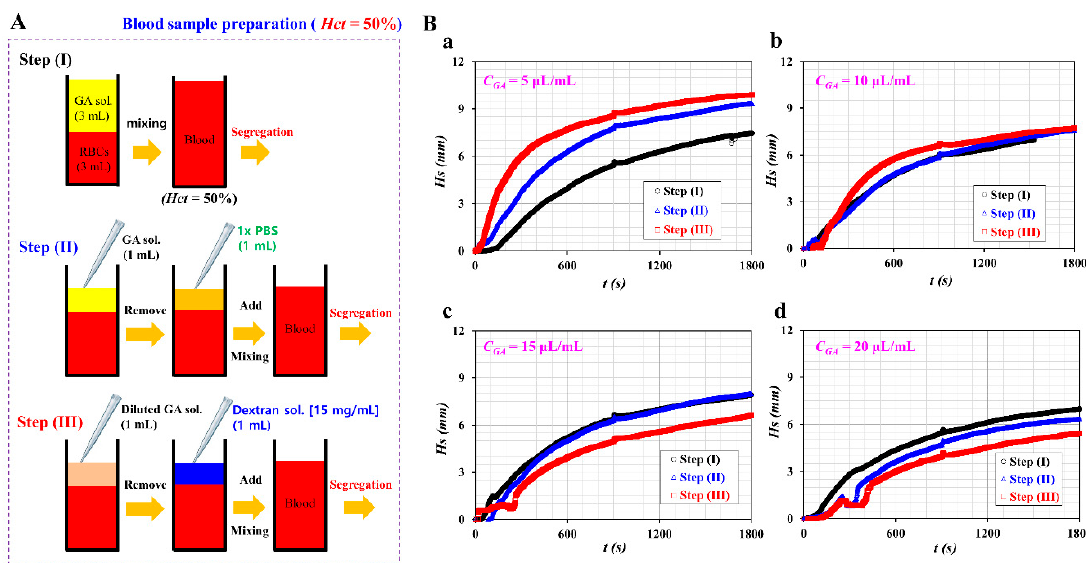
Figure 6. Measurement of separation height ( Hs ) after adding normal RBCs into GA solution, 1x PBS, and dextran solution ( C dex = 15 mg / mL). ( A ) Schematic of the three steps for preparing blood sample. ( a ) Step (I): normal RBCs (3 mL) and a specific concentration of GA solution (3 mL) were infused and mixed in blood container. ( b ) Step (II): after operating ultrasonic transducer for 30 min, GA solution (~1 mL) was removed from top layer. 1x PBS was then added and mixed in blood container. ( c ) Step (III): after operating ultrasonic transducer for 30 min, diluted GA solution (~1 mL) was removed